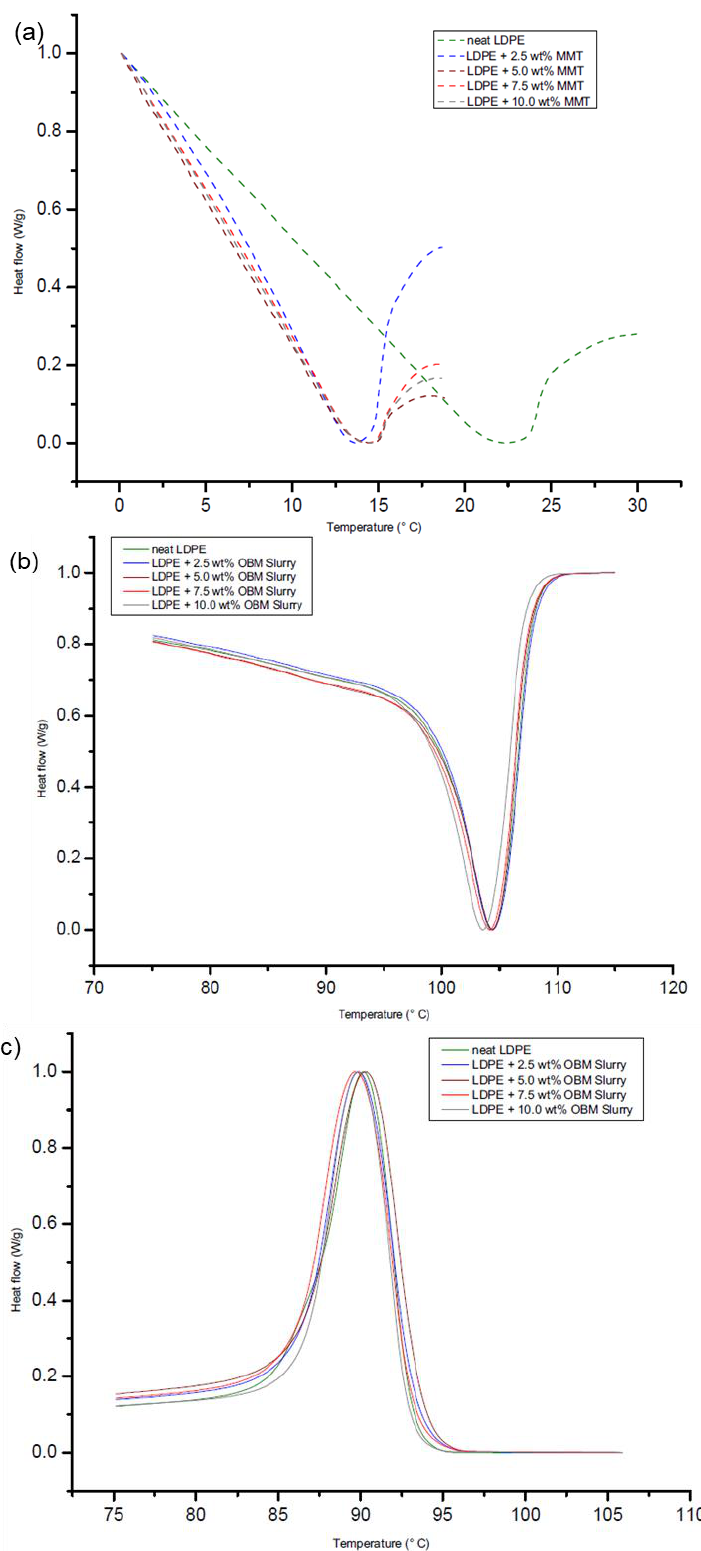
Figure 15. DSC thermograms of LDPE and LDPE/MMT nanocomposites at ( a ) glass transition temperature (Tg); and LDPE and LDPE/OBM slurry nanocomposites at ( b ) melting temperature (Tm) and ( c ) crystallisation temperature (Tc).